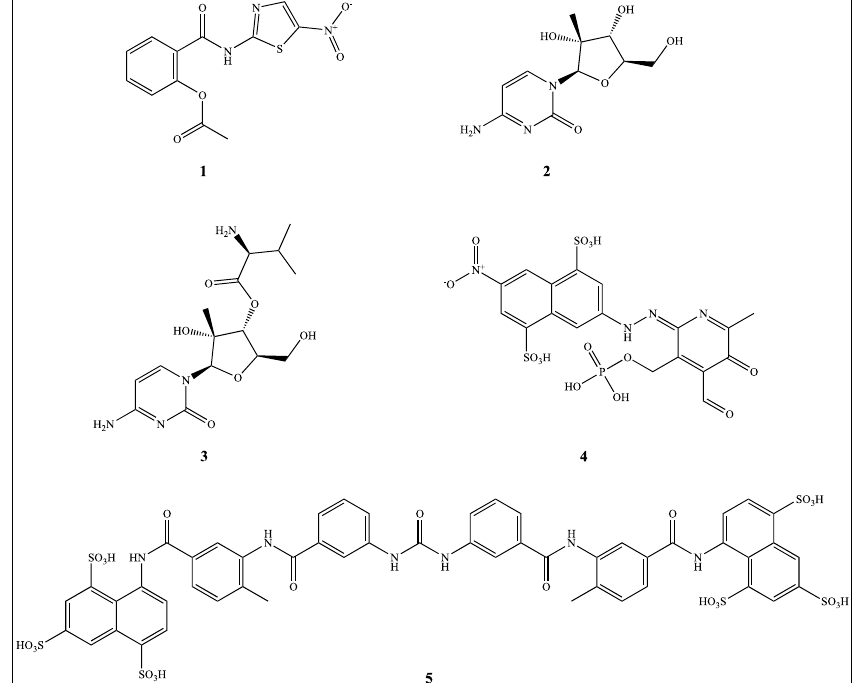
Figure 1. Norovirus inhibitors in pre-clinical studies. Nitazoxanide ( 1 ), 2 ′ -C-methylcytidine ( 2 ), valopicitabine ( 3 ), PPNDS ( 4 ), suramin ( 5